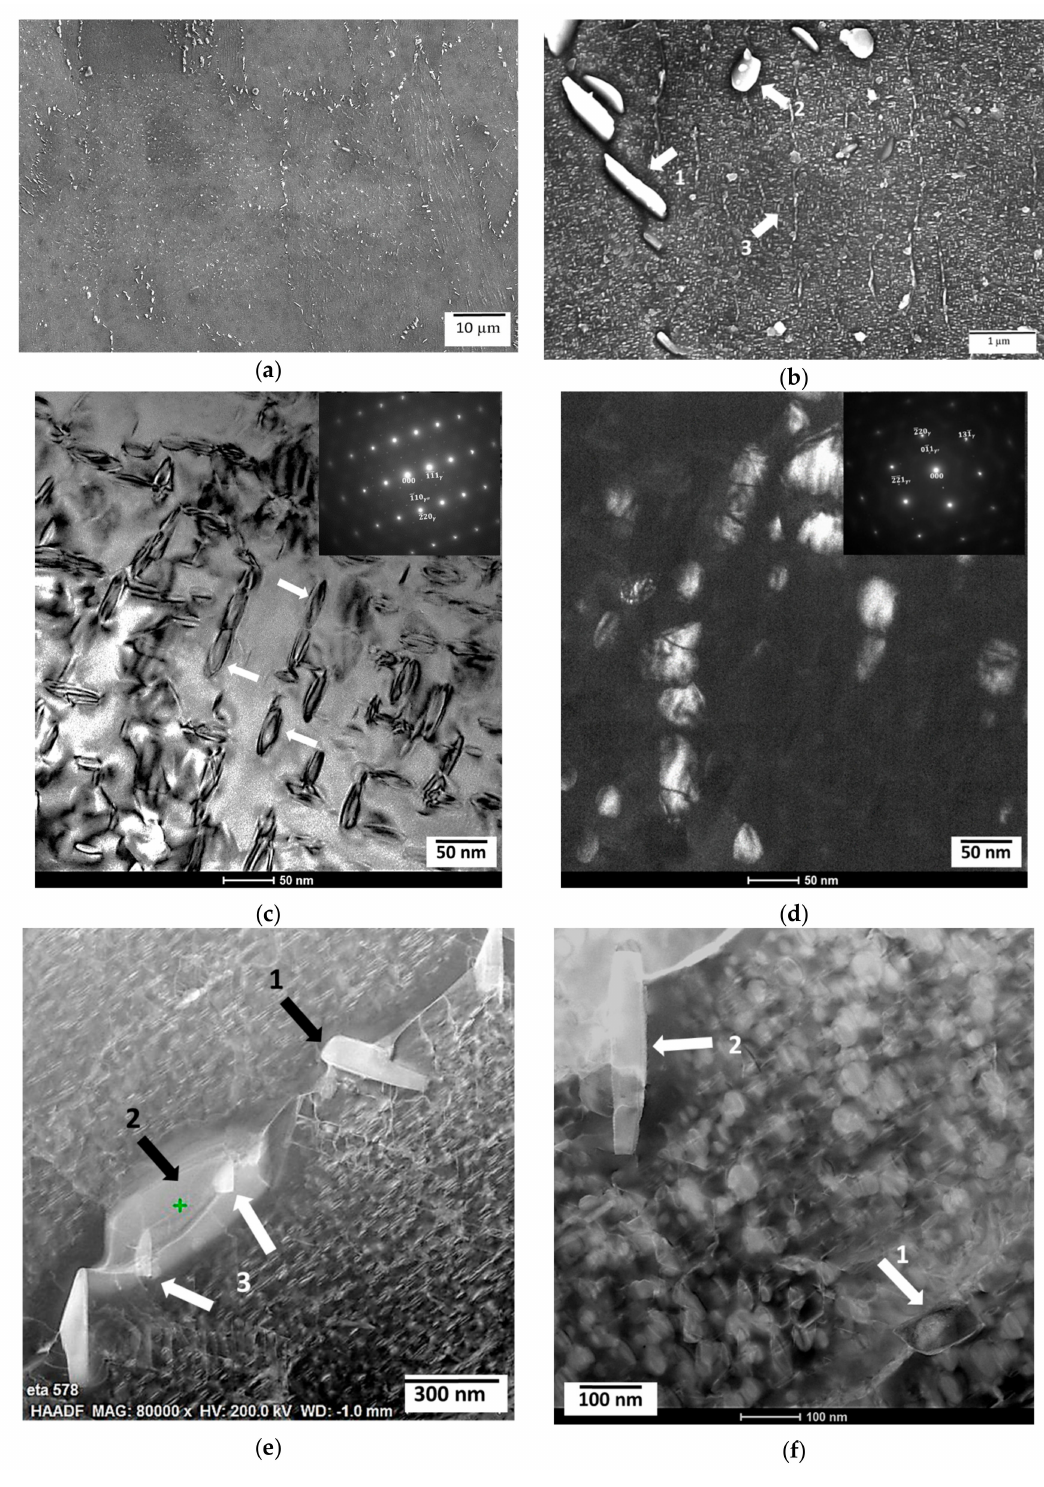
Figure 4. ( a ) Microstructure of solution and aged heat treated (SHT + AGE) condition showing ( b ) (1) delta phase, (2) MC-type carbide, and (3) matrix with strengthening phases γ ’ and γ ” (electrolytically etched with phosphoric acid); ( c ) bright field image of γ ” (marked with white arrows),the inset shows the di ff raction pattern of γ ” in γ -matrix; ( d ) dark field image of same area as (c), showing y’ (white particles), the inset shows the di ff raction pattern of γ ’ in γ -matrix; ( e ) TEM HAADF image showing (1) δ -phase residing on the grain boundary, (2) Laves phase, and (3) δ -phase forming from the Laves phase; and ( f ) TEM HAADF image of (1) NbC and (2) δ -phase residing on the grain